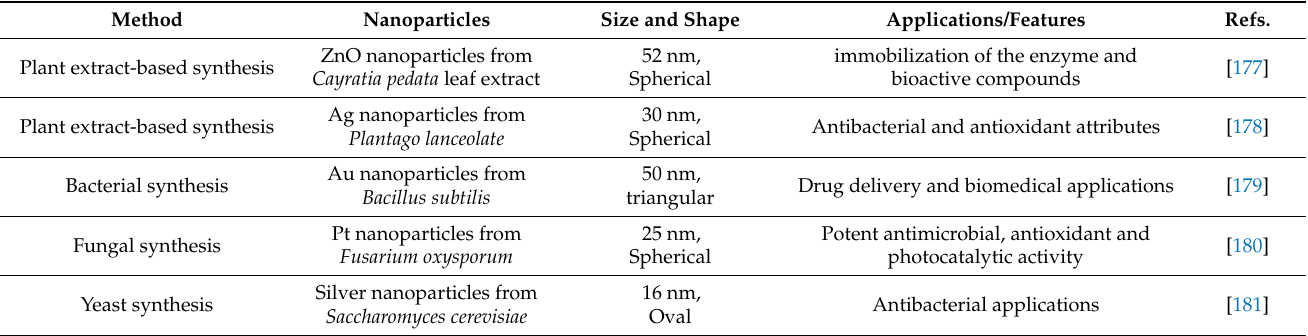
Table 4. Biological approaches to synthesize nanoparticles and